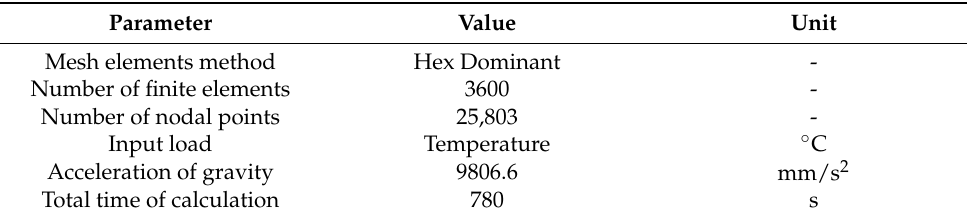
Table 3. FE numerical simulation data of the second stage of analysis.